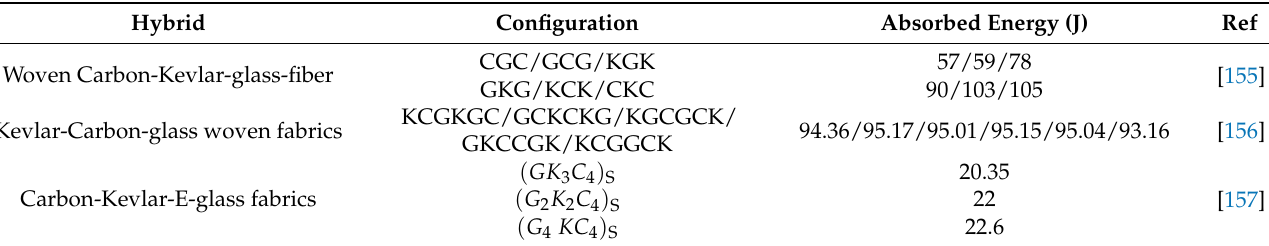
Table 3. Energy absorption of hybrid composite with various configurations. Hybrid